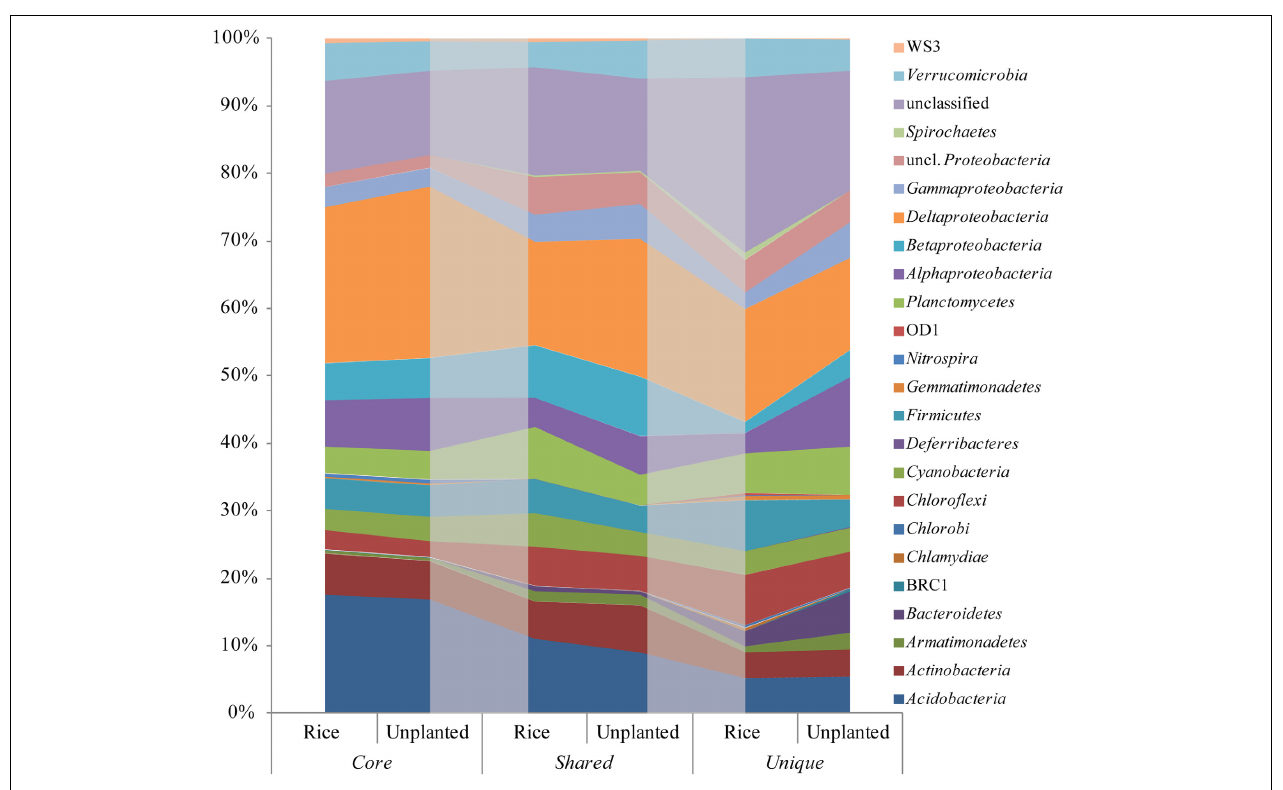
FIGURE 6 | OTU based relative sequence abundance of bacterial phyla based on 16S rRNA in the rice and unplanted fields. OTUs detected in all fields (core), only in unplanted and rice cultivated fields